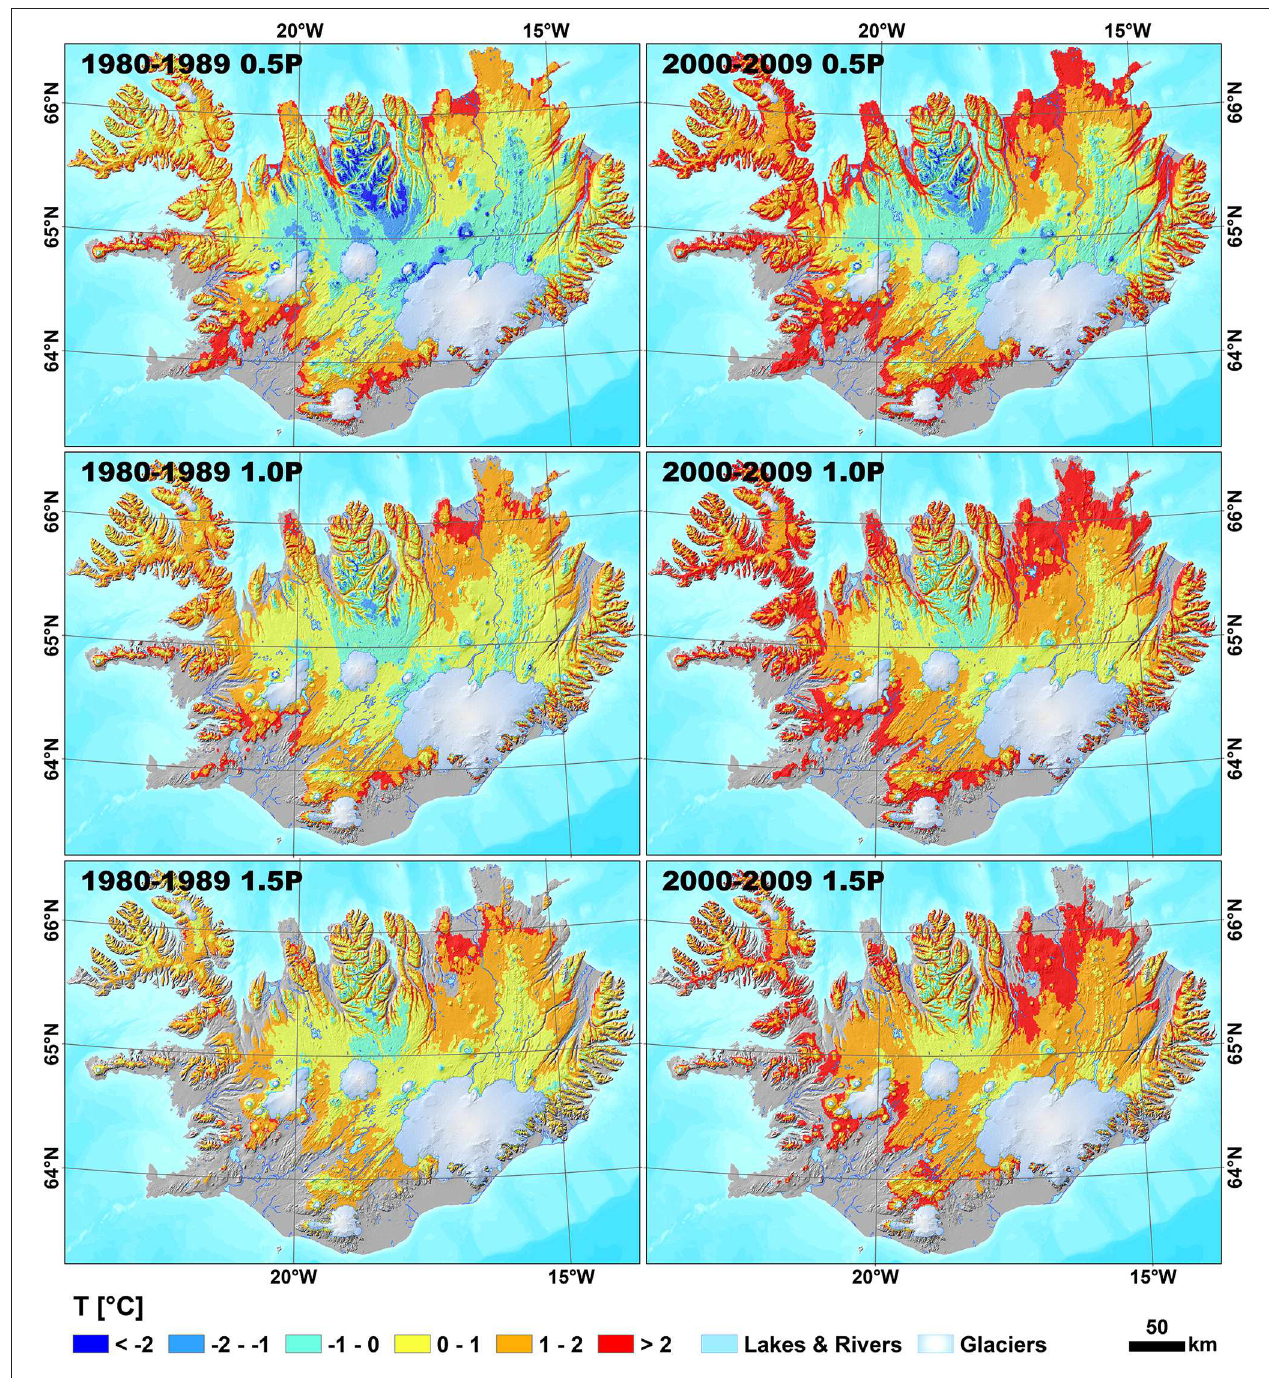
FIGURE 8 | Distribution of the simulated average ground temperature (T) at 2m depth in the periods 1980–1989 and 2000–2009 for the three precipitation cases: 0.5P-50% precipitation, 1.0P-100% precipitation, 1.5P-150% precipitation. Permafrost cells are displayed in blue hues. Map data from NLSI.